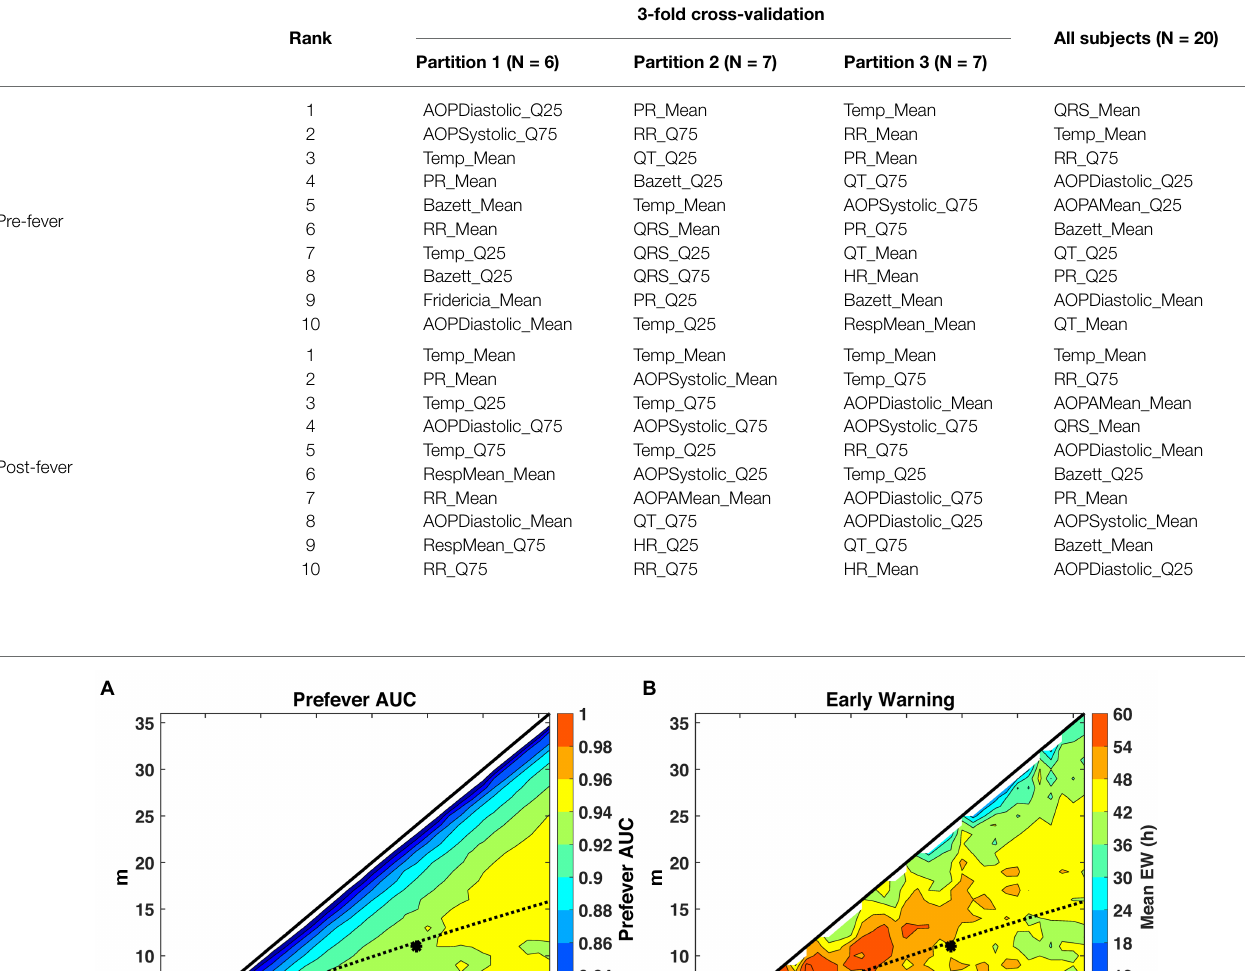
TABLE 4 | Ranked importance of the 10 selected features for models trained with subjects from MARV IM, MARV aerosol and EBOV aerosol. 3-fold Rank